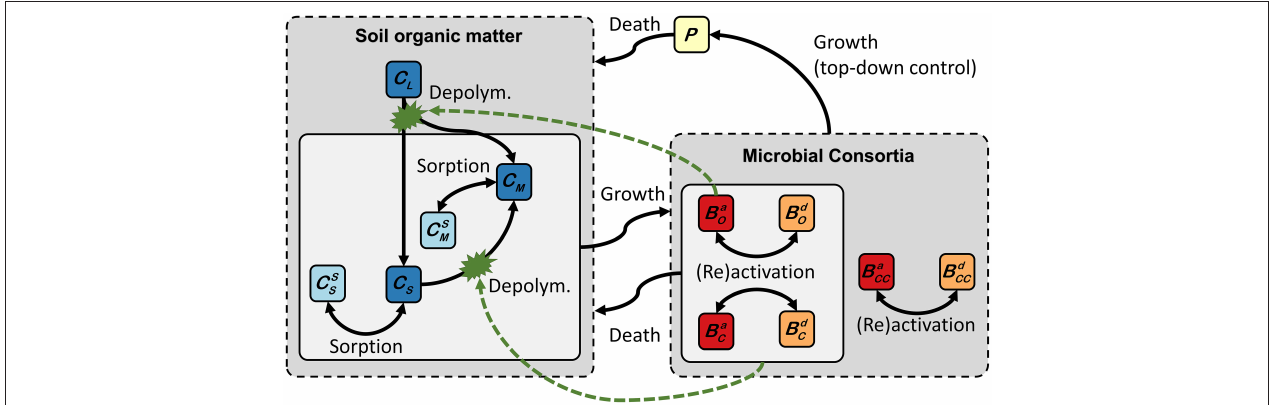
FIGURE 1 | Conceptual scheme of coupled carbon turnover and biochemical interactions implemented in the 2D spatially explicit trait-based soil C model (SpatC). Solid arrows indicate carbon fluxes. Dashed green arrows depict the controls on extracellular depolymerisation reactions. C M , C S , and C L stands for monomers, small polymers, and large polymers, respectively. Superscript “S” indicates sorbed phase concentration of C M and C S . Monomers and small polymers may be transported by 2D diffusion (not shown). Microbial communities consist of active (superscript “a”) and dormant (superscript “d”) oligotrophs (B O ), copiotrophs (B C ), and copiotophic cheaters (B CC ). P stands for